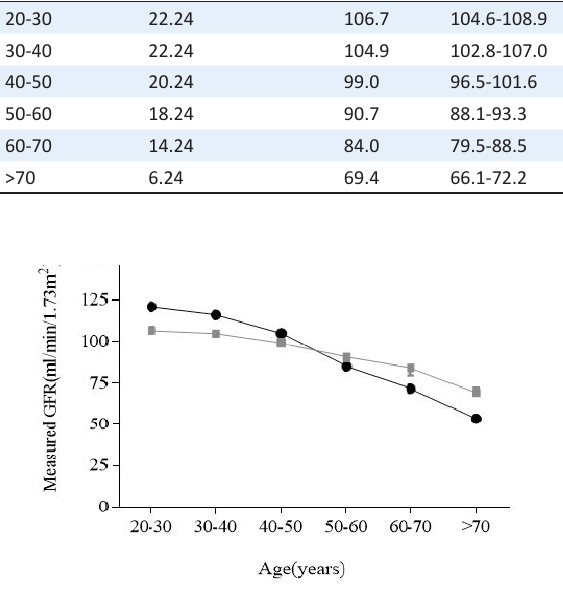
Table 3. Mean and confidence interval obtained from the meta-analysis study for GFR (ml/min/1.73 m 2 ) Age groups